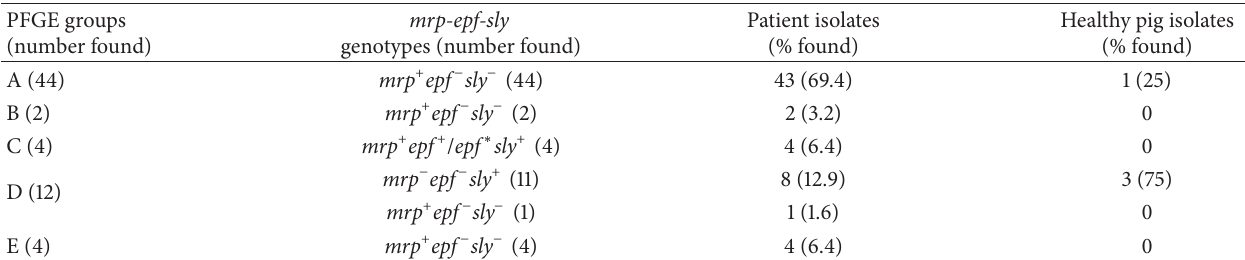
Table 1: Correlation between PFGE groups and mrp - epf - sly genotypes of S. suis serotype 2 isolated from 62 patients and 4 healthy pigs. PFGE